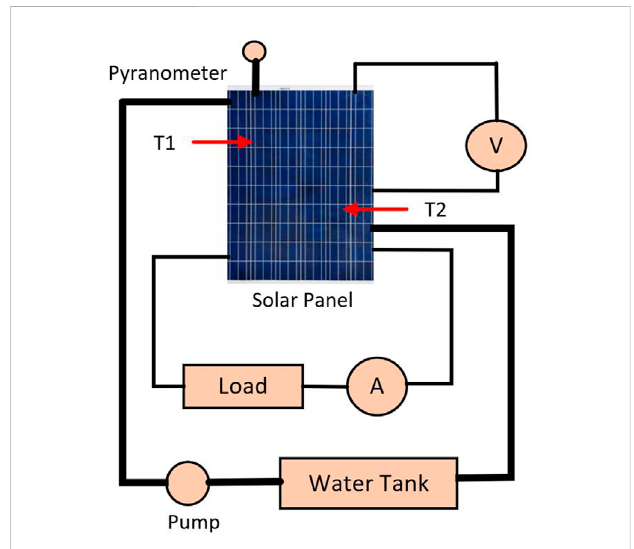
FIGURE 4 Schematic representation of a simple water-based cooling system that can be implemented for